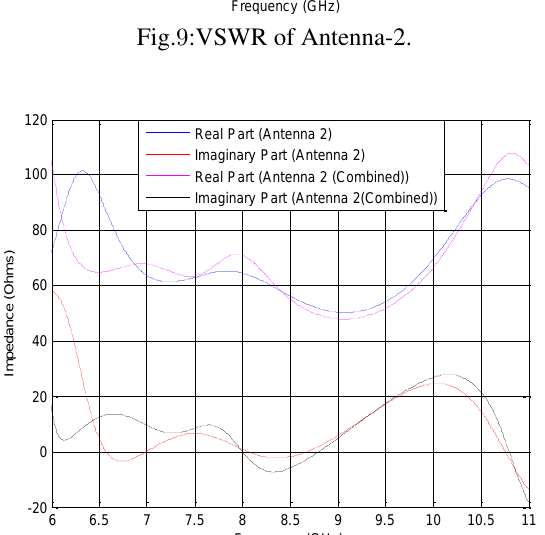
Fig. 7 : Input impedance of Antenna-1.